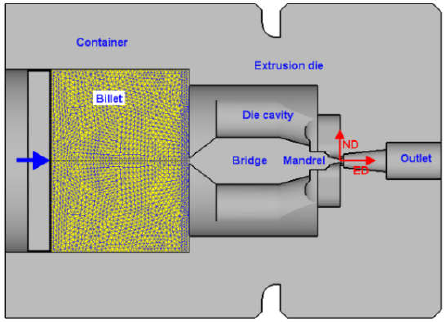
Figure 3. The finite element model generated by Deform